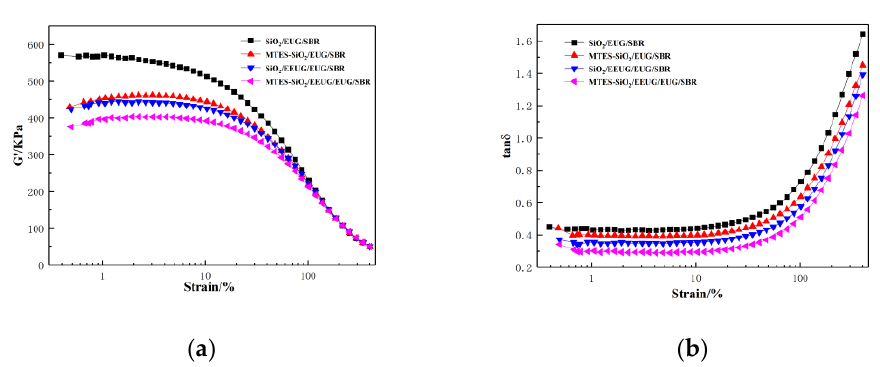
Figure 8. Rubber processing analyzer (RPA) curves of rubber composites: ( a ) G (cid:48) –strain curve; ( b ) tan δ –strain